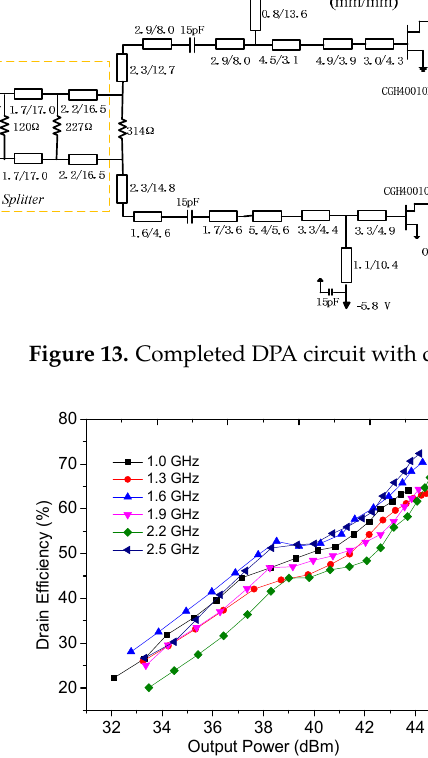
Figure 14. Simulated drain efficiency versus output power.